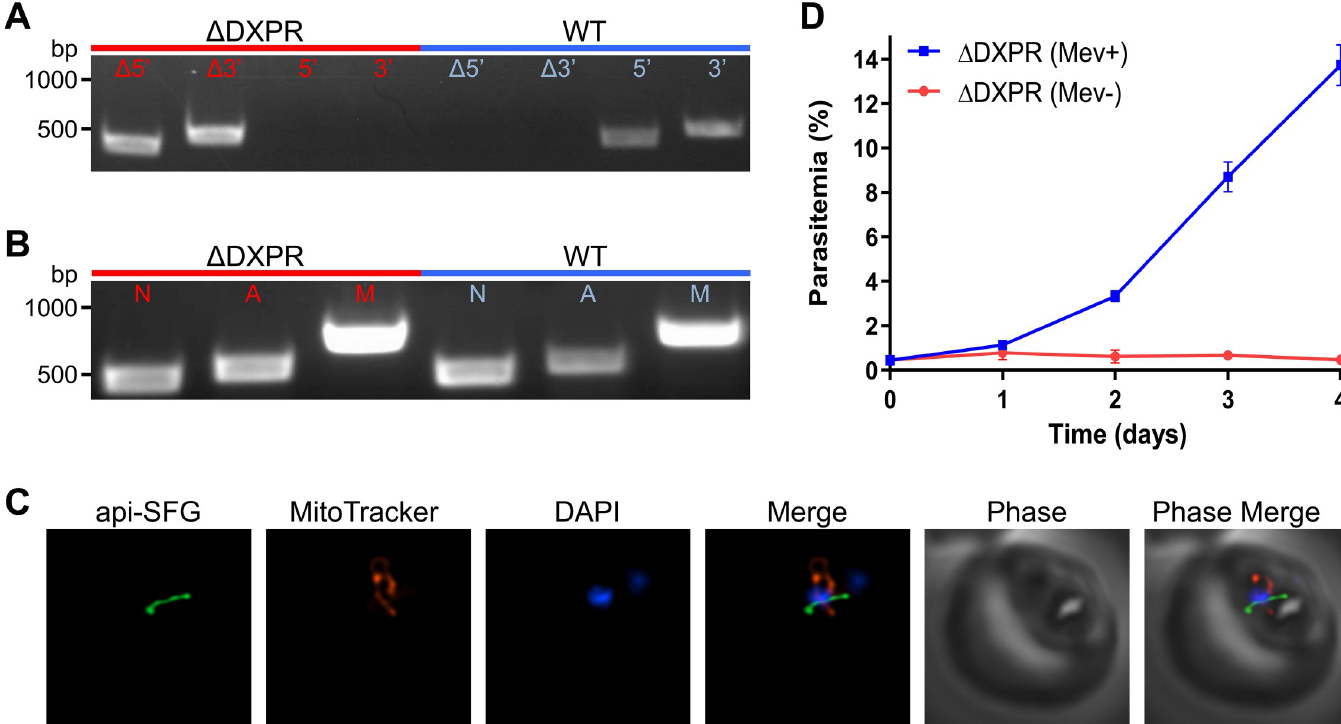
Fig 6. Deletion of the fosmidomycin drug target DXPR. A) Confirmation of DXPR gene deletion via PCR showing the expected 5’ and 3’ integration of the selection cassette. Δ dxpr parasites (red) were also screened for the unmodified 5’ and 3’ loci to detect if there were any residual wild-type parasites and compared to a control (blue). B) PfMev Δ dxpr parasites were screened for the presence of the nuclear ( ldh ), apicoplast ( sufB ), and mitochondrial ( cox1 ) genomes via PCR (red), and compared to a control (blue). Both lines showed the presence of nuclear, apicoplast and mitochondrial genomes, indicating deletion of DXPR does not result in organelle loss. C) Live epifluorescence microscopy of the PfMev Δ dxpr parasites showing the presence of an intact organelle. The apicoplast is labeled with the api-SFG protein (green), the mitochondrion is stained with MitoTracker (red), and nuclear DNA is stained with DAPI (blue). Images depict fields that are 10 microns long by 10 microns wide. D) PfMev Δ dxpr parasites grown in the presence of 50 μ M mevalonate (blue) or no mevalonate (red). Error bars represent the standard error of the mean from three independent experiments, each conducted in quadruplicate. The reliance of PfMev Δ dxpr parasites on mevalonate for growth indicates that DXPR is essential for the blood-stage survival of the